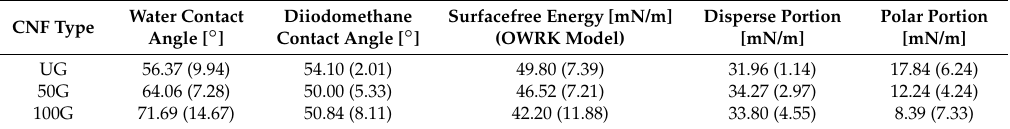
Table 2. Surface properties of films made from different CNF suspensions at room temperature.